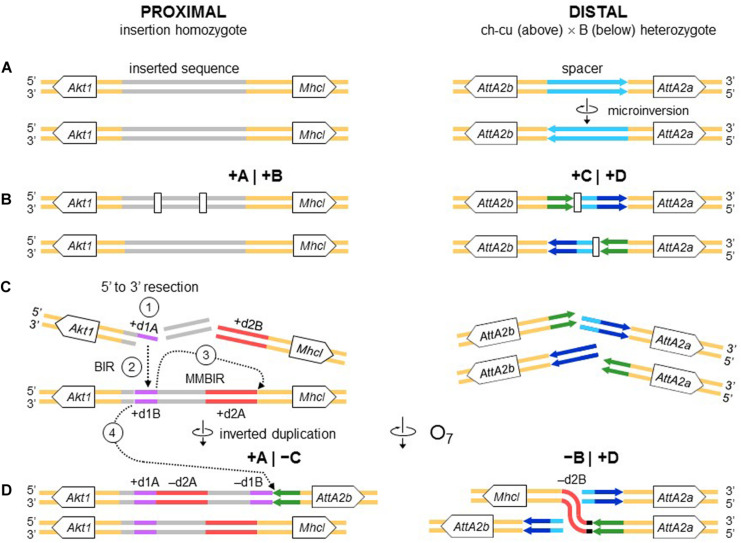
Chromosome and BIR/MMBIR repair model of O7 formation. (A) Start as in Figure 9. (B) Occurrence of one pair of blunt-ended DSBs (open rectangles) at the proximal breakpoint of the ch-cu type chromosome, and as in Figure 4 at the distal breakpoint. (C,D) Step 1: 5′ to 3′ resection generating a 3′ single stranded + d1A end. Step 2: beginning of a BIR event via strand invasion into the homologous region of the B-type chromosome. Step 3: switch from BIR to MMBIR, with forward template switching to the distal end of + d2A and backward copying. Step 4: MMEJ to the distal break-end of O7 from the original ch-cu–type chromosome. The distal breakpoint repaired as in Figure 9. The model results in an order of the duplications (i.e., + d1A, -d2A, -d1B, -d2B) identical to that resulting from the model of Figures 4, 9.